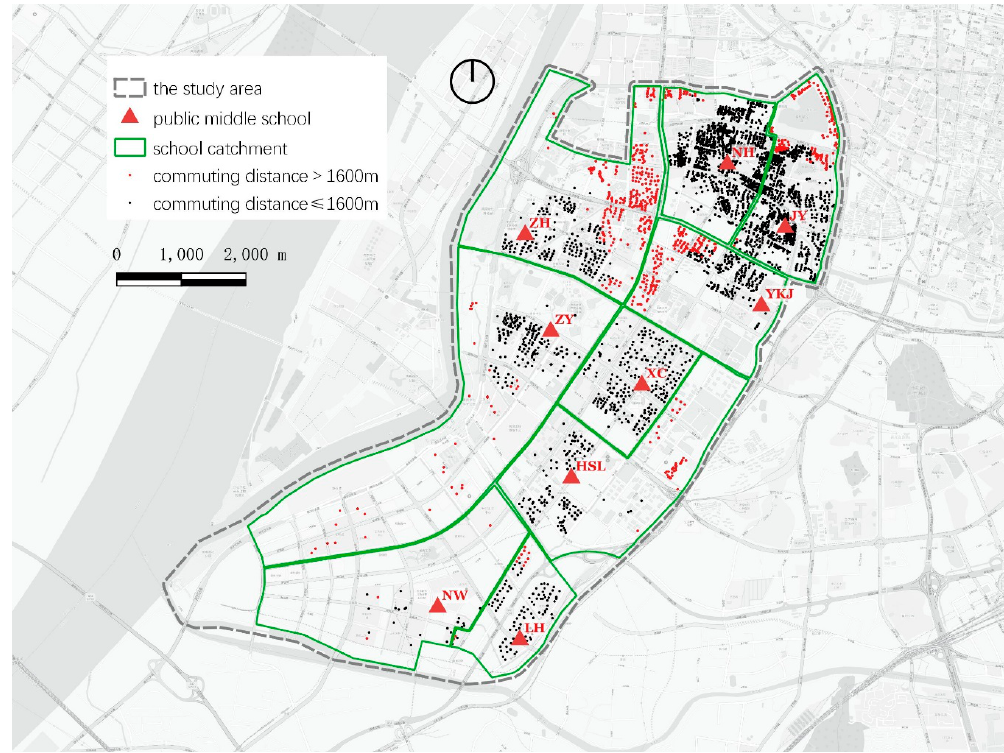
Figure 5. Residence points division by threshold of commuting distance (1600 m).